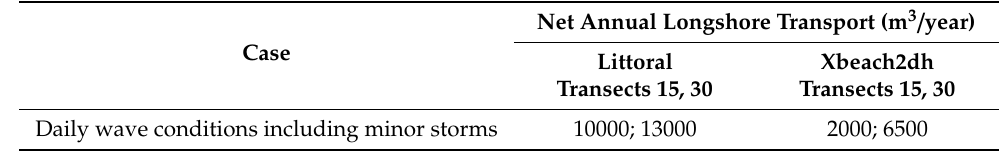
Table 5. Net annual longshore transport; d 50 = 0.4